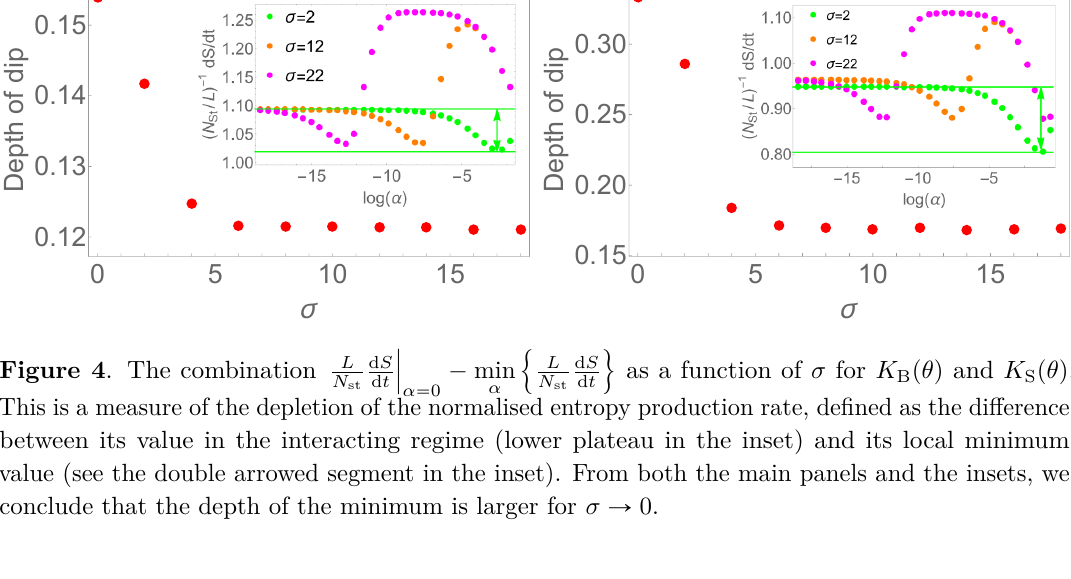
and K . B p θ q S p θ q